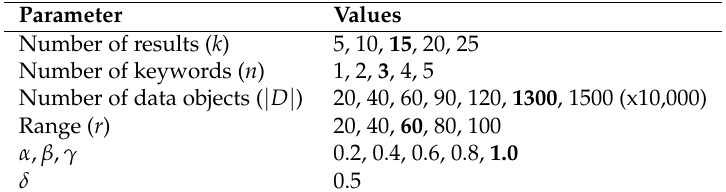
Table 5. Experimental parameter